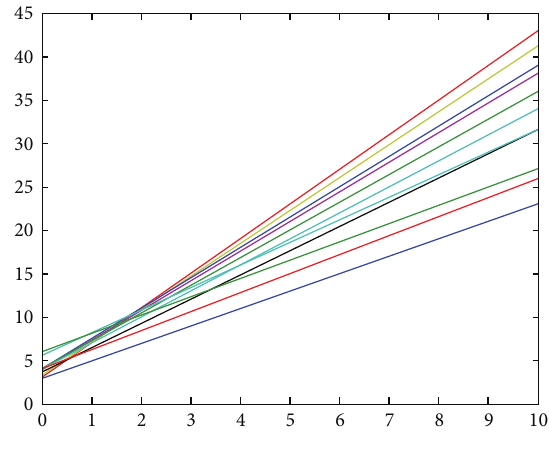
Figure 1: The differences of the